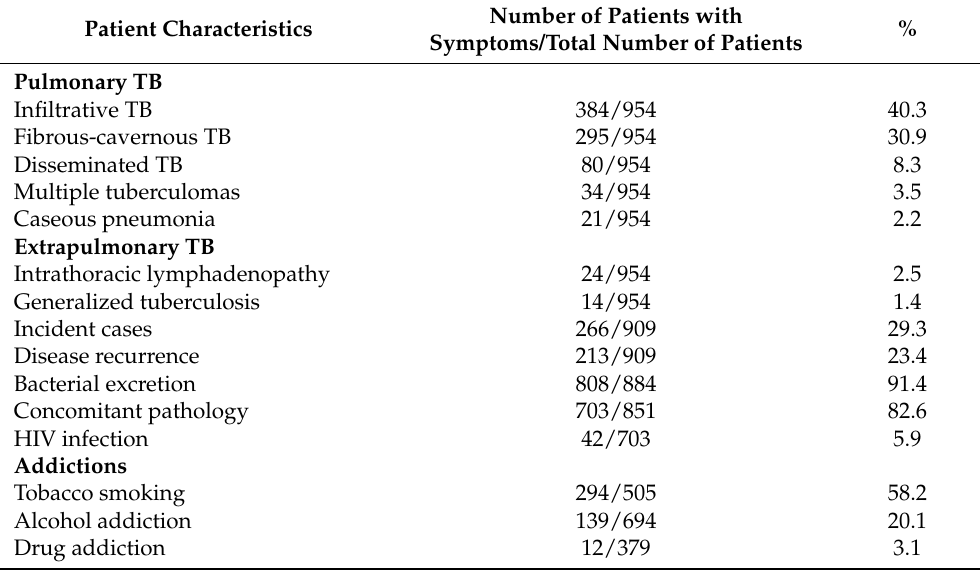
Figure 1. Study design and selection of publications. Table 2. General characteristics of treated patients with